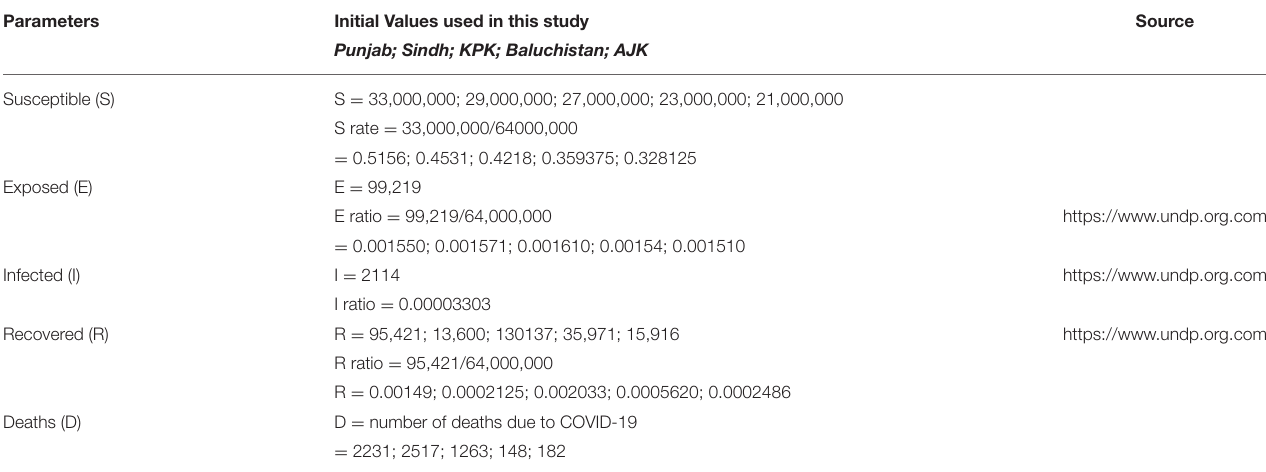
TABLE 2 | The results of SEIRD parameters.